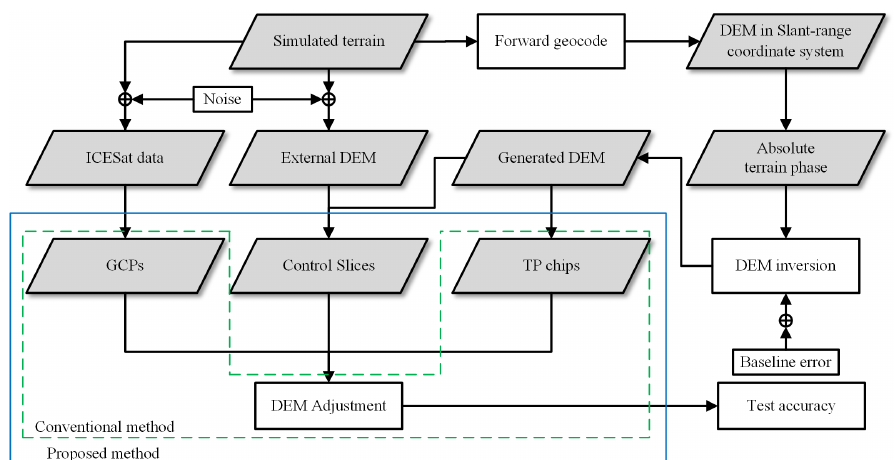
Figure 6. The workflow of the simulated experiment, including all processing steps from simulat- ing external terrain to DEM block adjustment.The green dotted line box represents the traditional adjustment method, and the blue solid line box represents the proposed method.